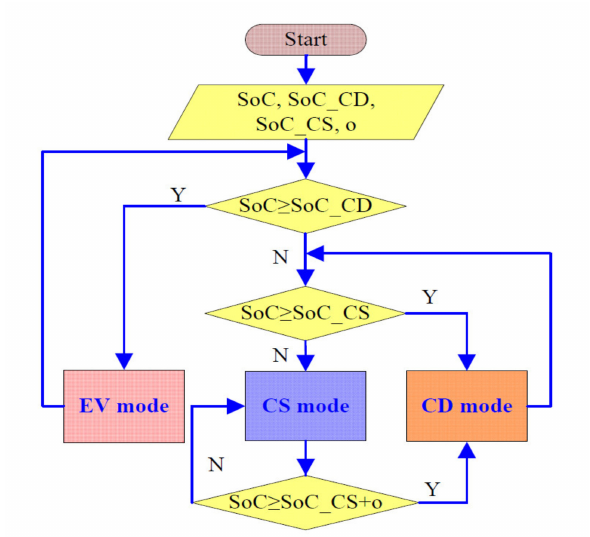
Figure 12. Schematic diagram of the mode switching control strategy